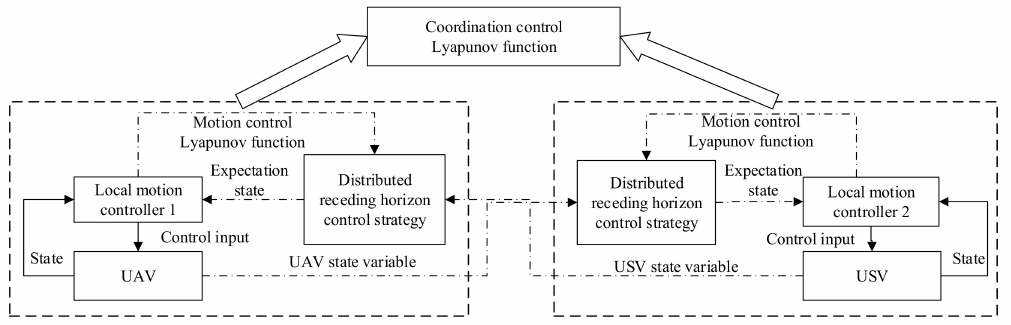
Figure 4. Cooperative control of heterogeneous